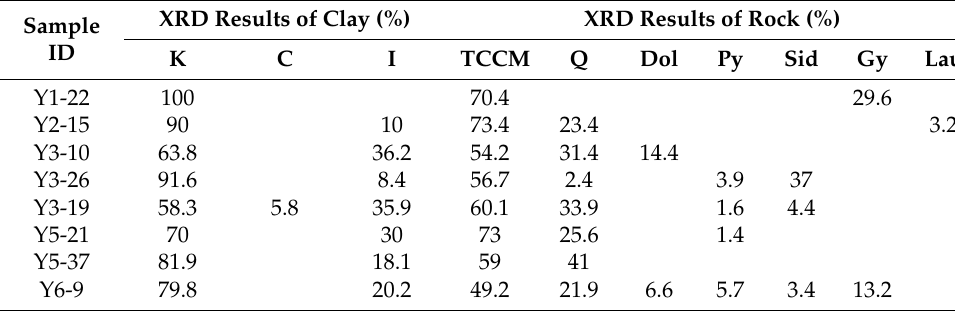
Table 2. The X-ray diffraction (XRD) test results of the shale